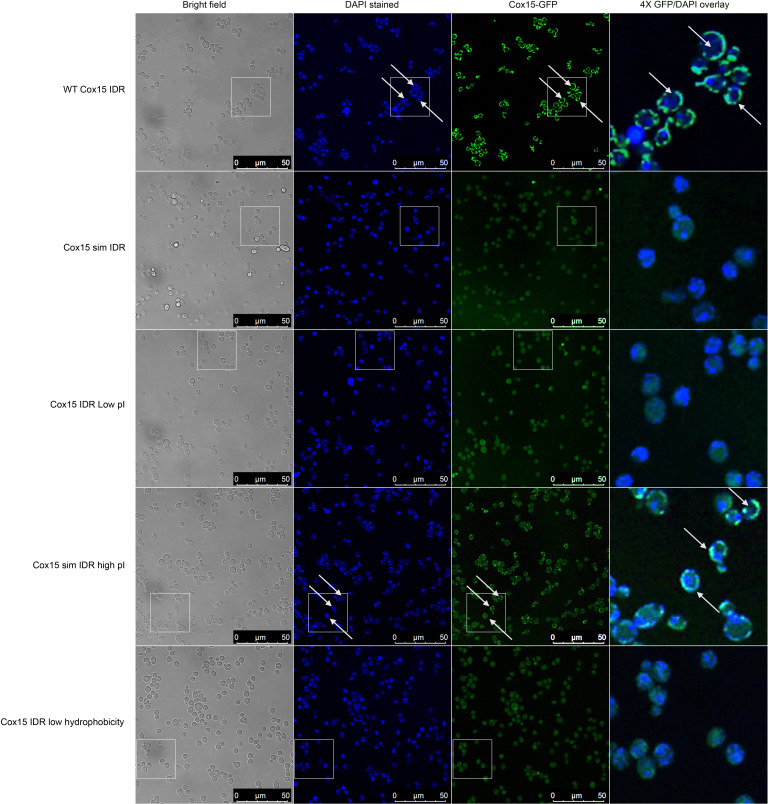
Micrographs showing (columns, left to right) bright-field, DAPI, Cox15-GFP, and 4× zoomed Cox15-GFP/DAPI overlay of different budding yeast strains with different Cox15 IDR genotypes (labels on left side of image).DAPI stains DNA in the nucleus and mitochondria. Cox15 WT and Cox15 sim IDR high pI strain images indicate that Cox15-GFP is localized to mitochondria in these strains, while Cox15-GFP is not localized to the mitochondria in Cox15 sim IDR, Cox15 IDR low pI, and Cox15 IDR low hydrophobicity. White boxes indicate 4× zoomed in areas that are shown in the right-most column. White arrows indicate areas where there is overlap of non-nuclear DAPI and Cox15-GFP (i.e., mitochondrial localization).